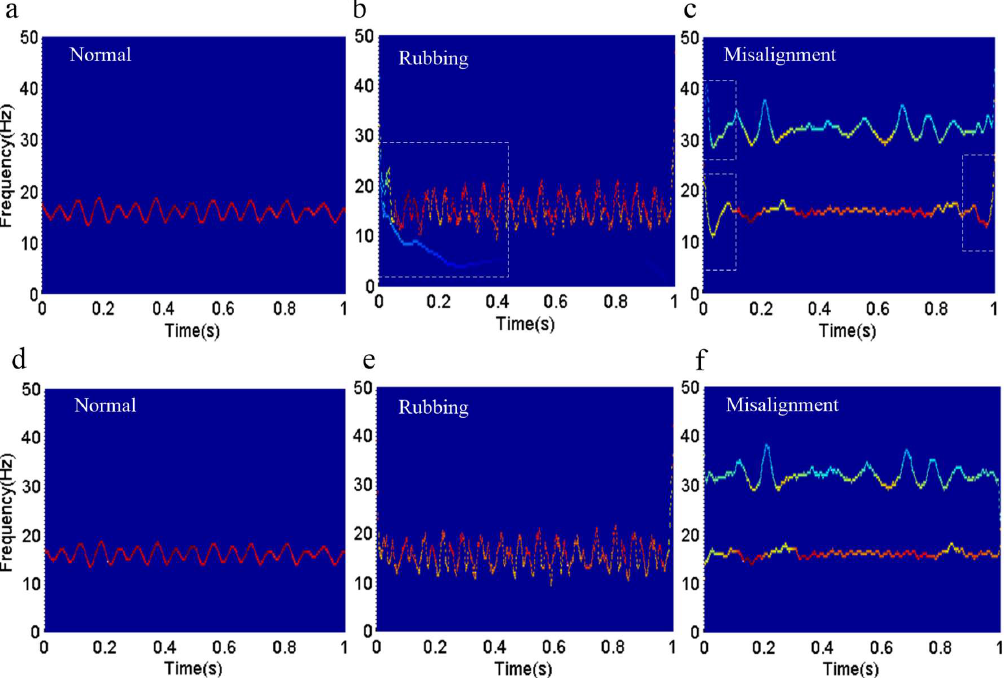
Figure 27. The time-frequency spectrum under different running states. ( a – c ) show the time-frequency spectrum of the normal, rubbing, and misalignment running states obtained by the original HHT; ( d – f ) show the time-frequency spectrum of the normal, rubbing, and misalignment running states obtained by the revised HHT.